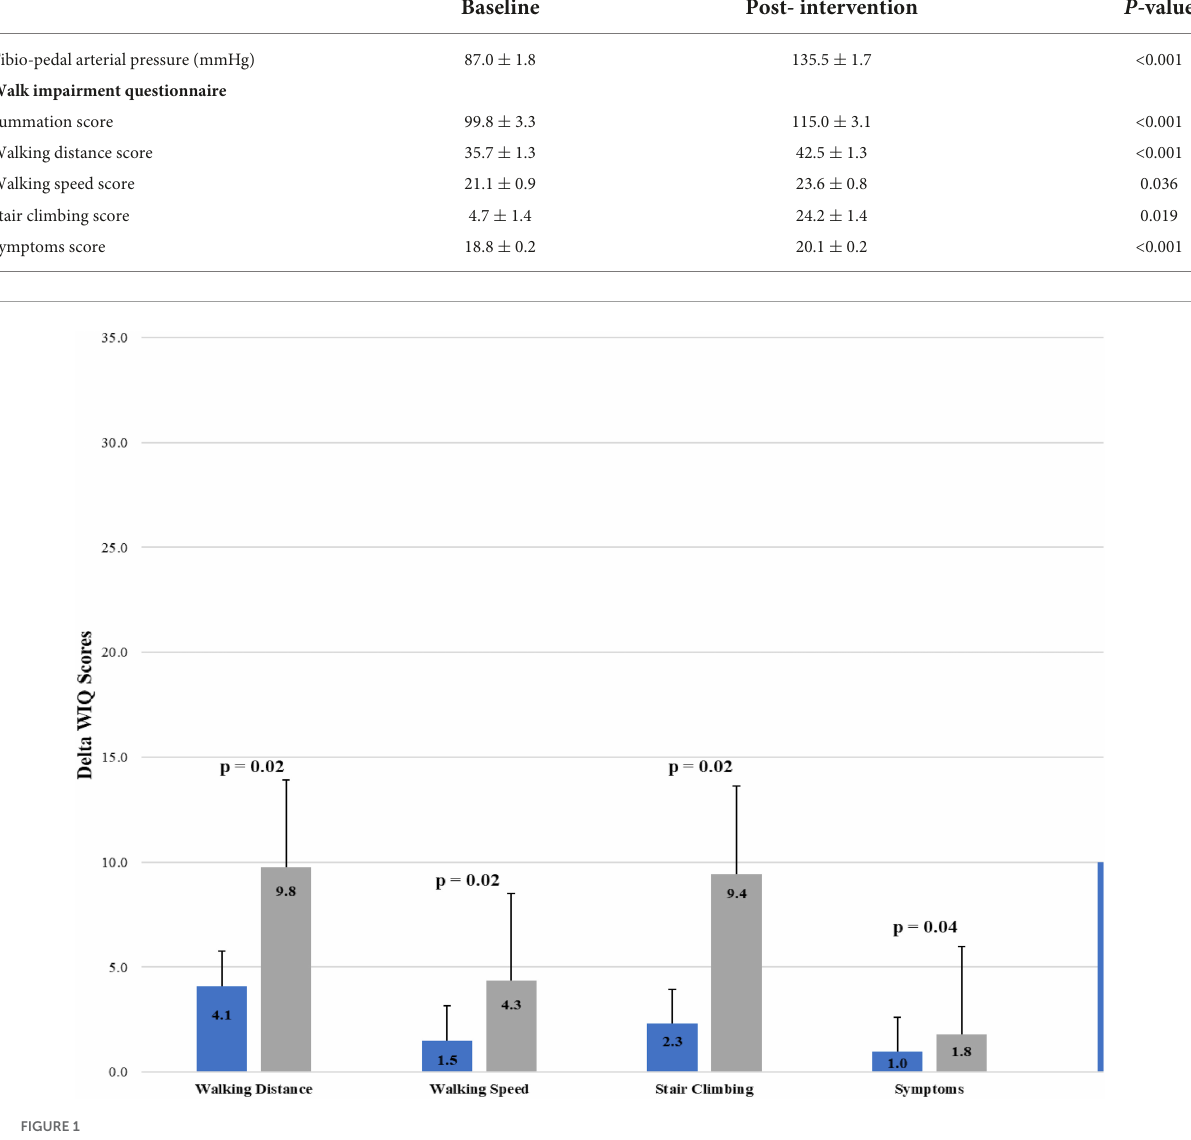
TABLE 3 Comparing the average tibio-pedal arterial pressures values, and average walking impairment questionnaire scores at baseline and post-intervention.